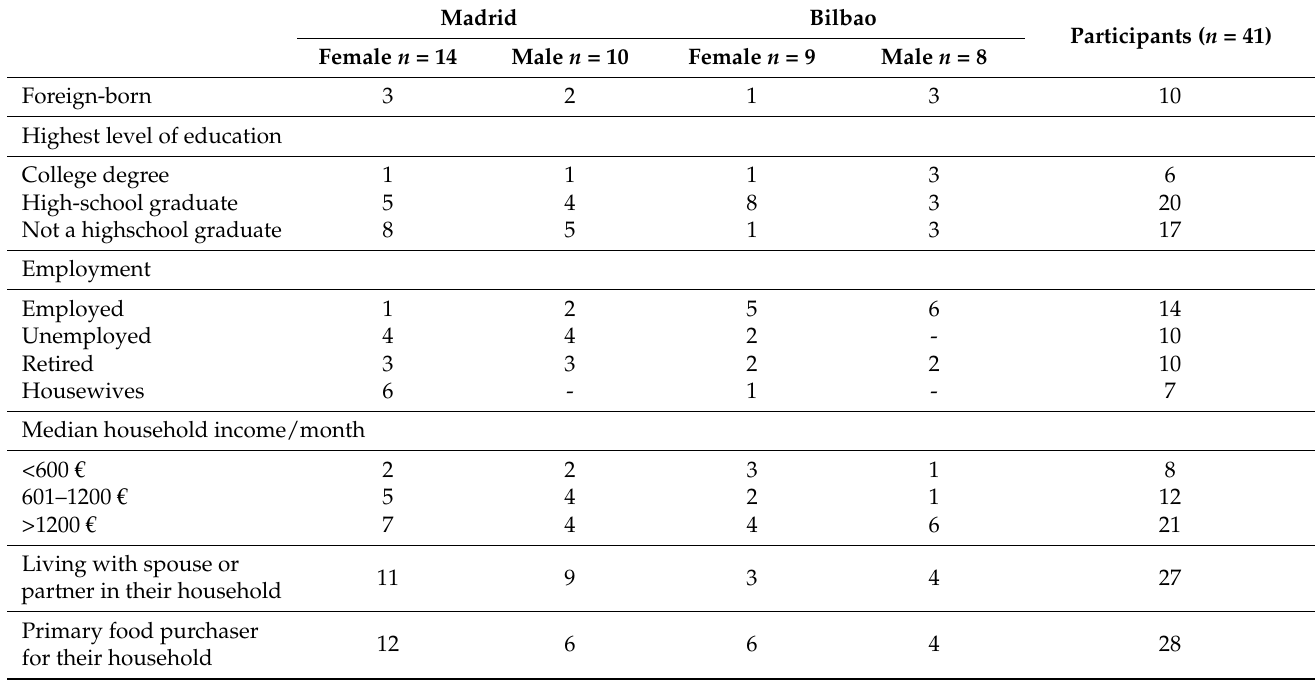
Table 1. Socio-demographic characteristics of the participants ( n = 41) by neighborhood and